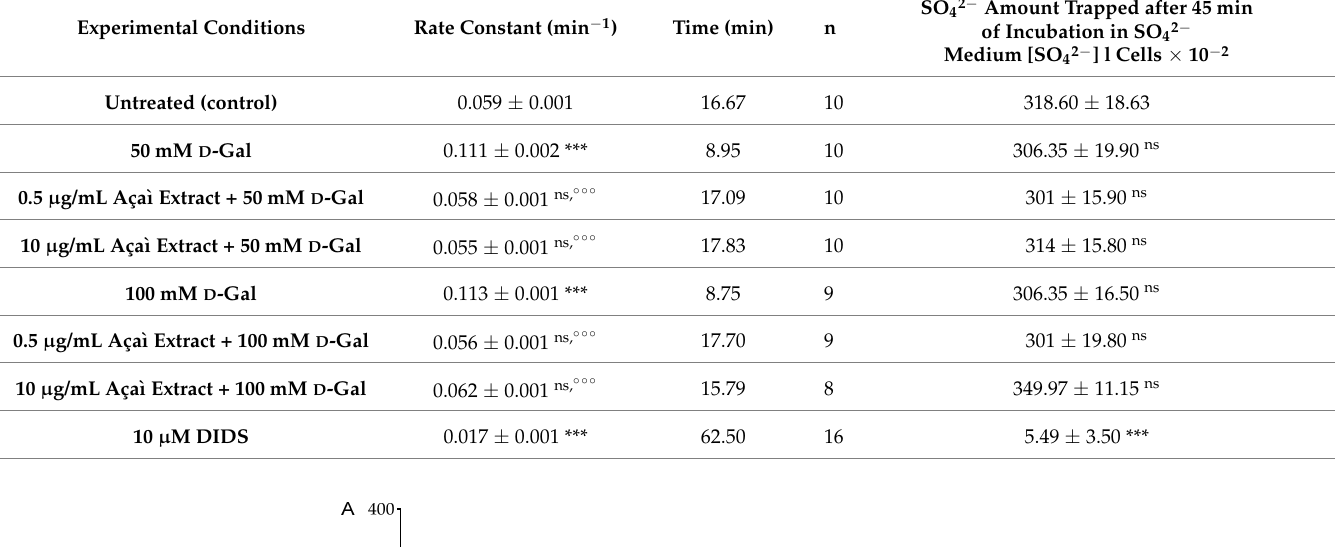
Table 2. Rate constant of SO 42 − uptake and amount of SO 42 − trapped in erythrocytes left untreated (control) and erythrocytes treated as indicated. Data are presented as means ± S.E.M. from separate ( n ) experiments, where ns , not statistically significant versus untreated; ***, p < 0.001 versus control; ◦◦◦ , p < 0.01 versus 50 or 100 mM D -Gal, one-way ANOVA followed by Bonferroni’s multiple comparison post-hoc test.